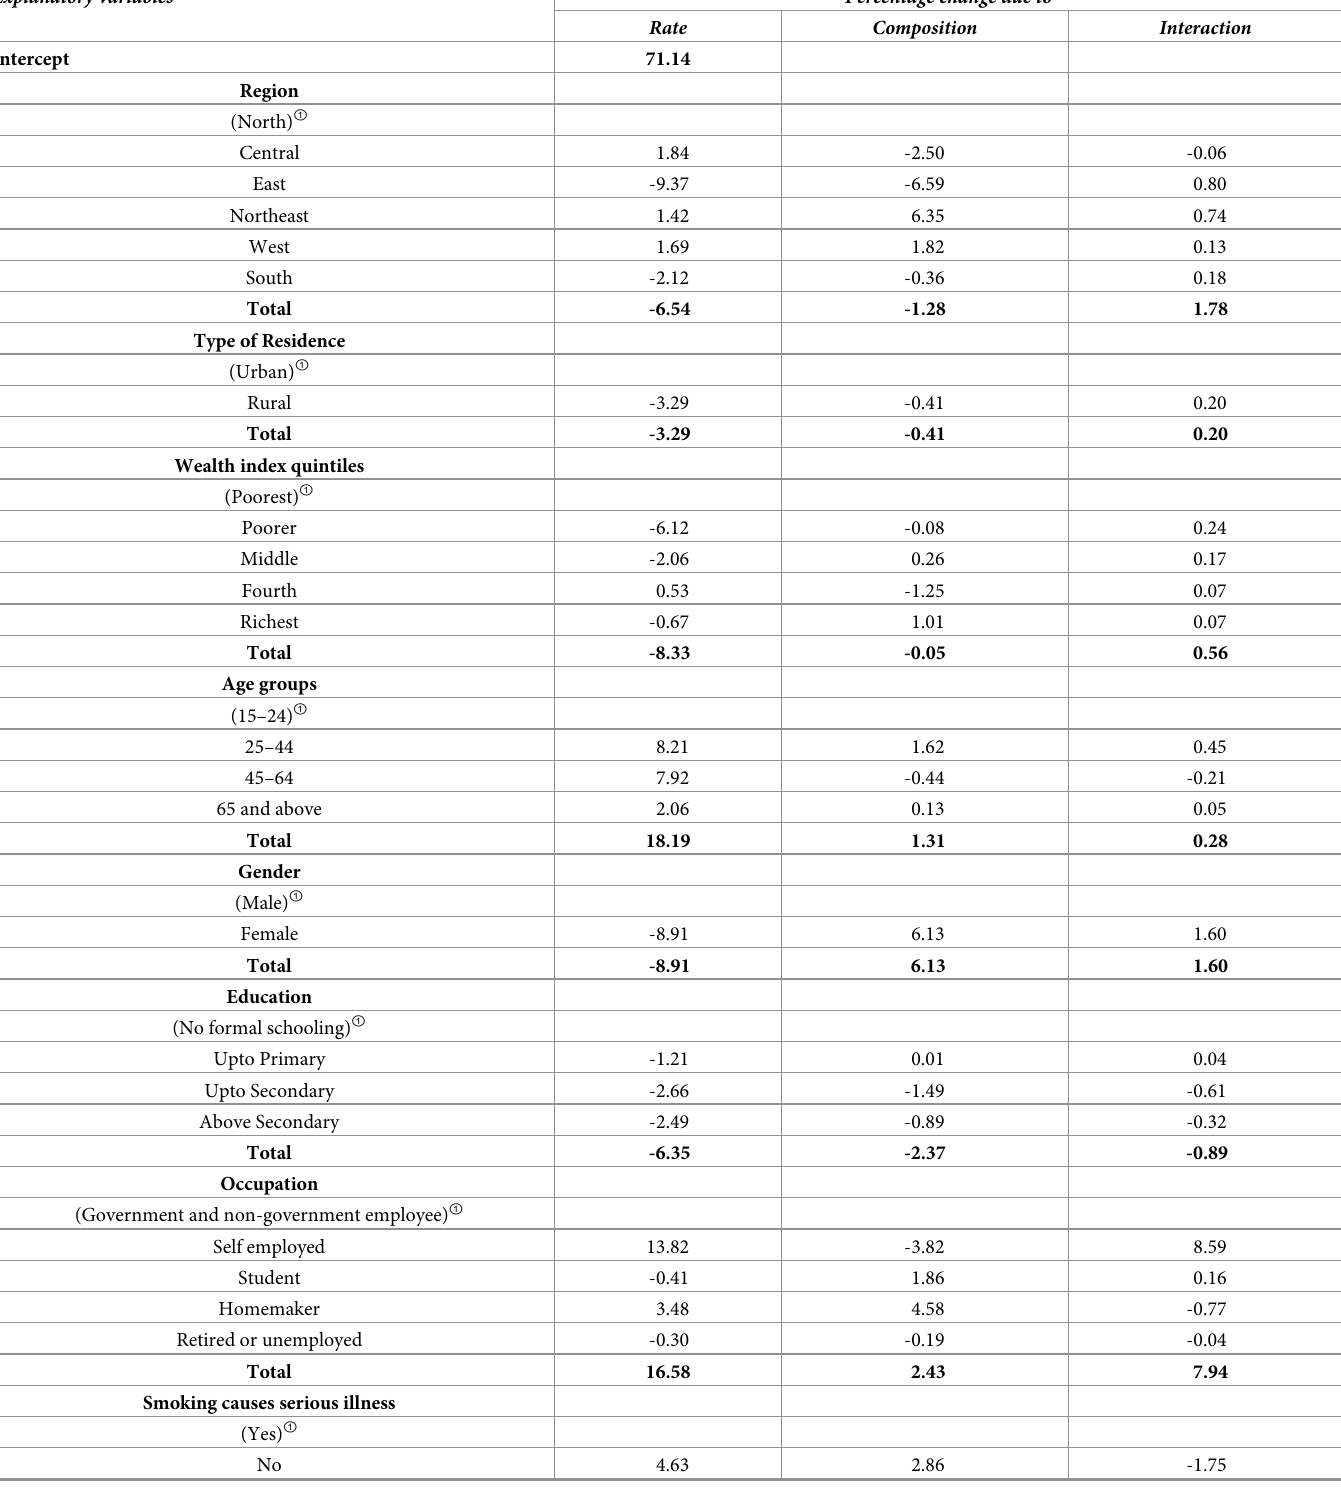
Table 5. Decomposition of change in smokeless tobacco consumption using multivariable binary logistic regression model in India, 2009–10 and